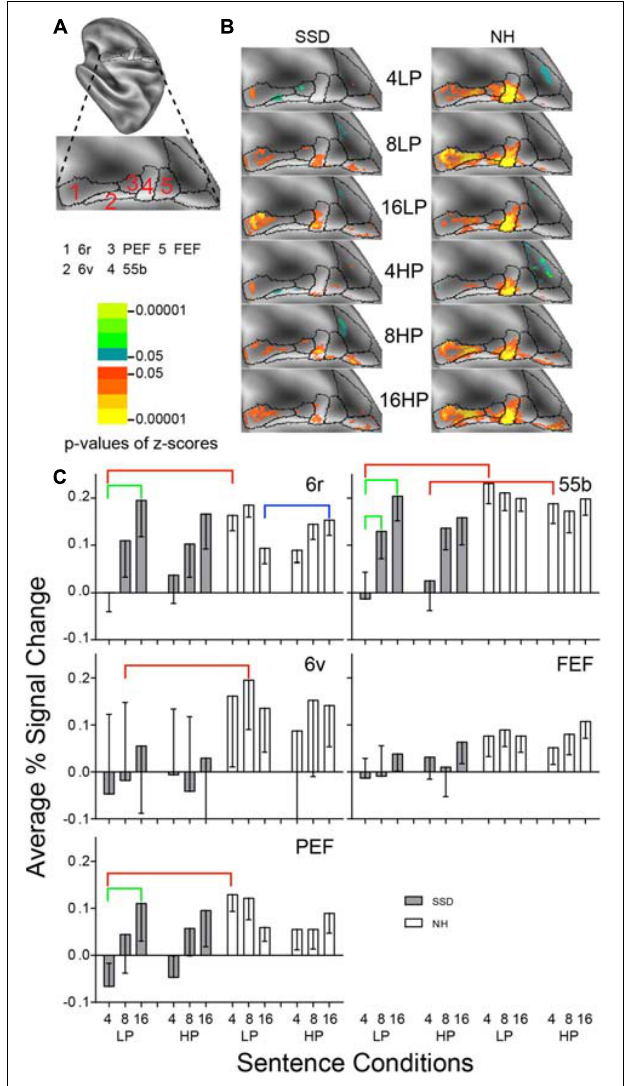
FIGURE 6 | Results from five parcels in the LH Premotor Cortex (PmC) region. (A) Lateral view of a partially inflated hemisphere rotated 45 degrees clockwise to align the PmC region horizontally. (B) Enlarged views of parcels show clusters with significant mean z-scores of p < 0.05 for positive BOLD (colored red-orange to bright yellow) and negative BOLD scaled blue to light green. (C) 6r, 6v, PEF, and 55b had significant group effects marked with red brackets. 6r, 6v, and 55b had significant intelligibility effects marked with green brackets. 6r had a significant predictability effect marked by a blue